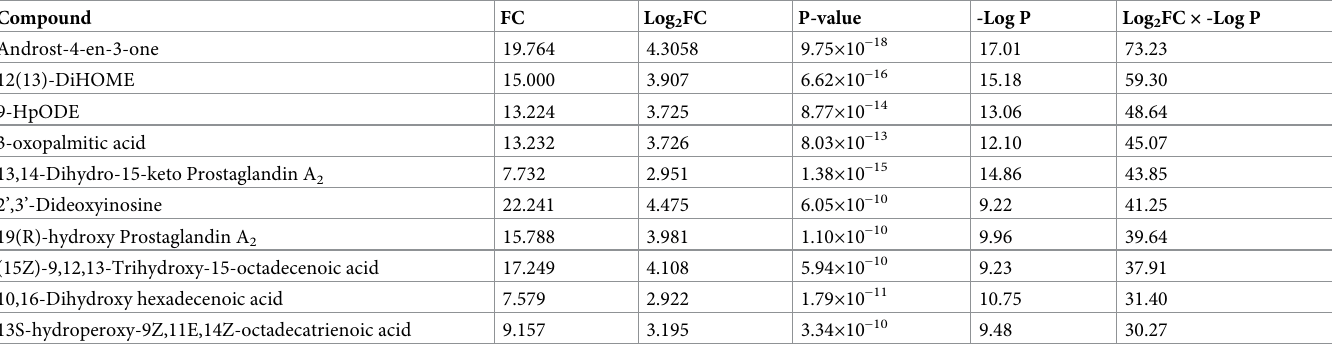
Table 3. Top 10 compounds upregulated in dogs with